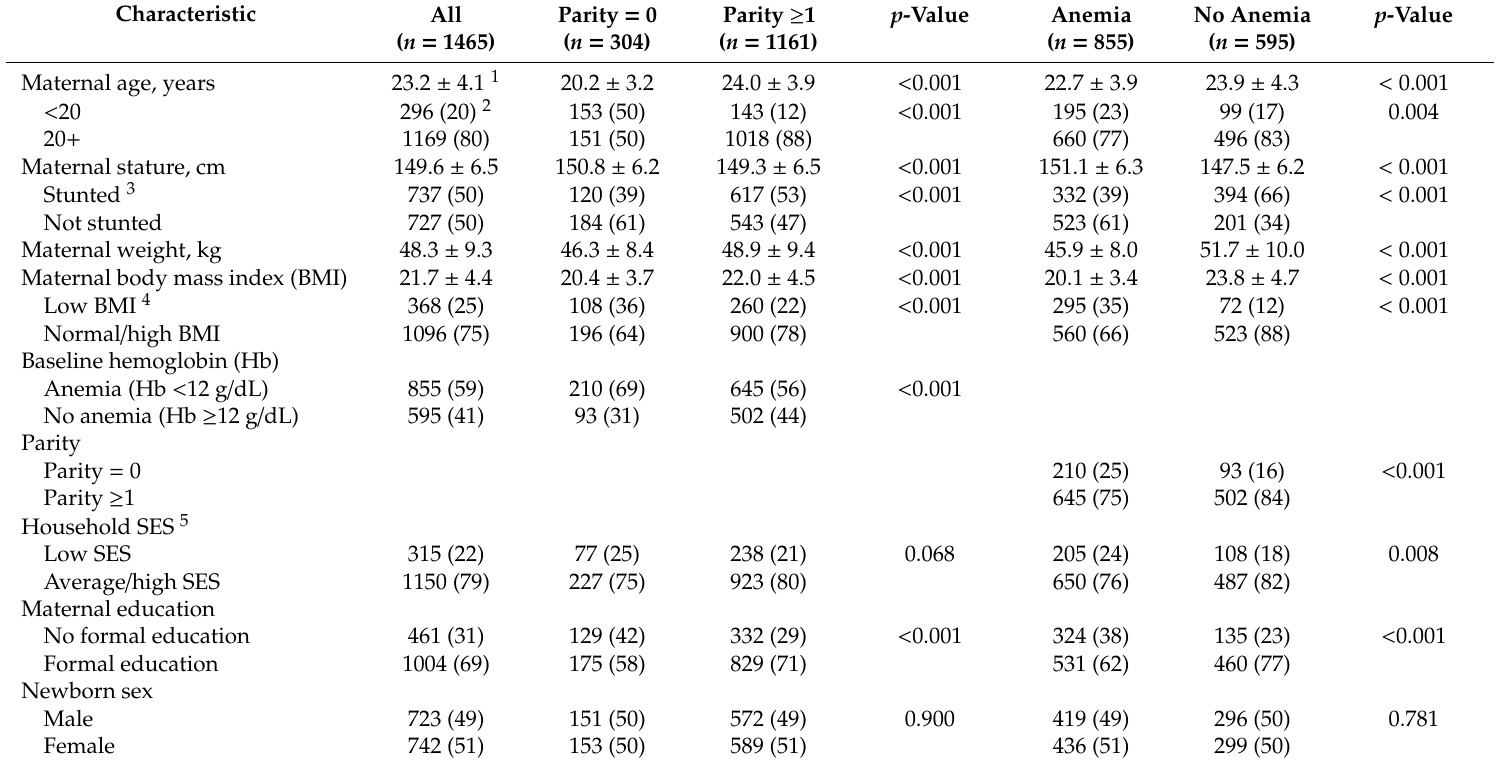
Table 2. Maternal characteristics, newborn sex, and risk factors by parity and anemia for combined sites.